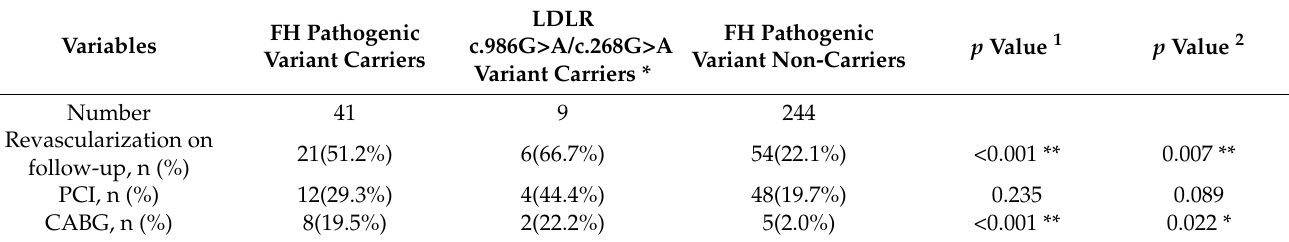
Table 3. Revascularization on follow-up. Comparison of FH pathogenic variant carriers, LDLR c.986G>A/ LDLR c.268G>A variant-carriers † and FH pathogenic variant non-carriers in subjects with high blood LDL-C levels who underwent coronary